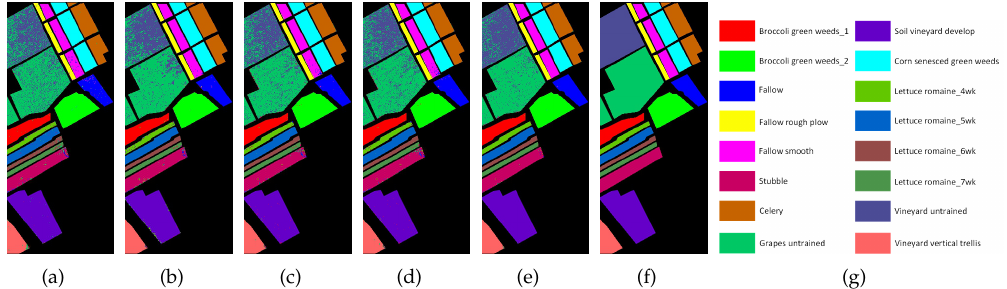
Figure 6. Classification maps for the Salinas data set obtained by different methods: ( a ) PCA; ( b ) ORF; ( c ) ORF-K-Means; ( d ) ORF-BIRCH; ( e ) PRF. In addition, ( f ) is the ground truth, and ( g ) is the